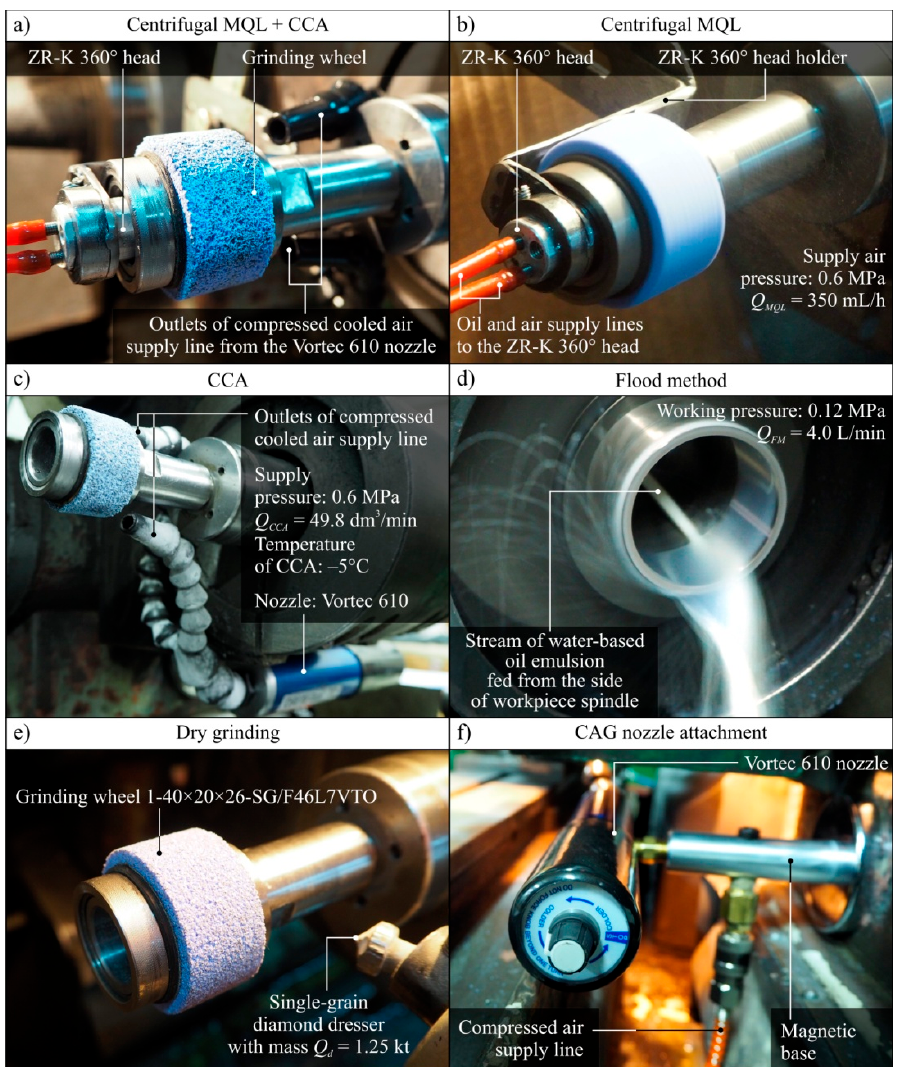
Figure 2. View of the machining zone for the five compared cooling and lubrication conditions: ( a ) centrifugal MQL and CCA; ( b ) centrifugal MQL; ( c ) only CCA; ( d ) flood method; ( e ) without coolants and lubricants (dry grinding); ( f ) fixing the CAG nozzle in the machining zone.